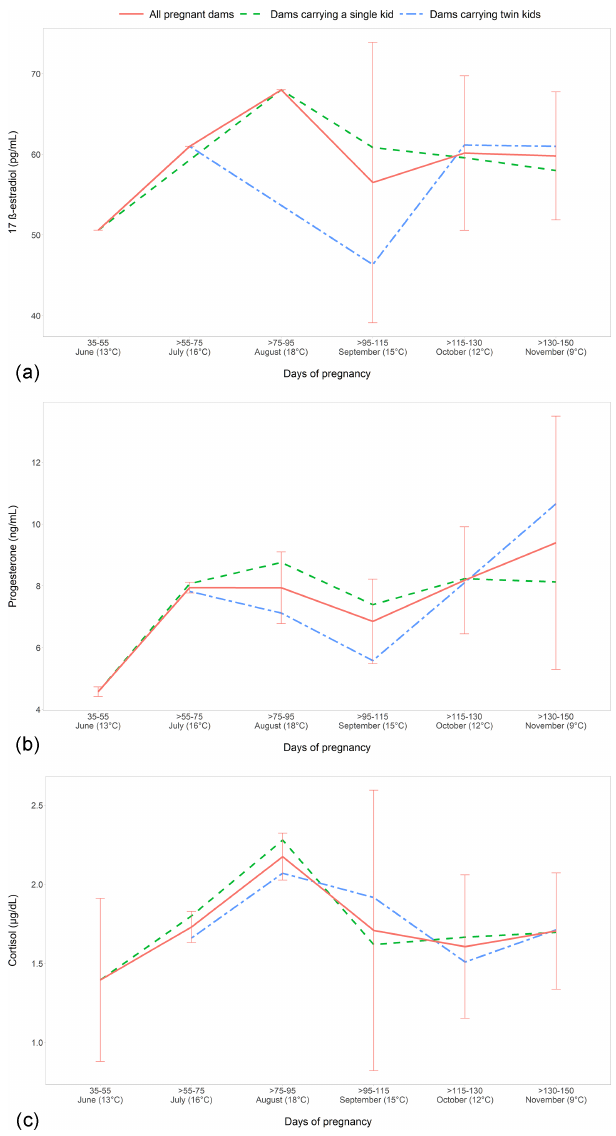
Figure 1. Circulating 17- β -estradiol (a) , progesterone (b) , and cortisol (c) concentrations (mean ± SD) in 30 pregnant Nicastrese goats.